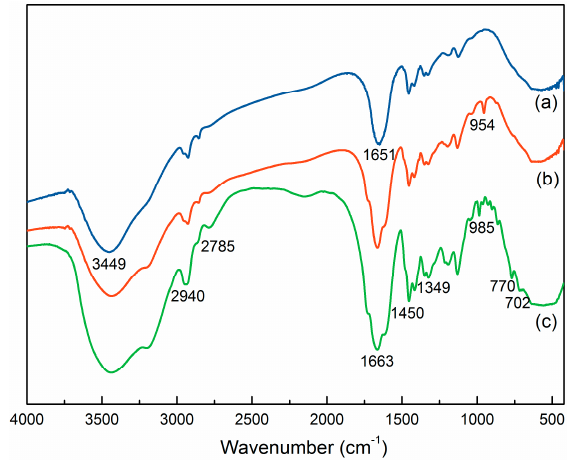
Figure 4. Fourier transform infrared (FTIR) spectra of ( a ) PAM; ( b ) PAD; ( c ) PAB.